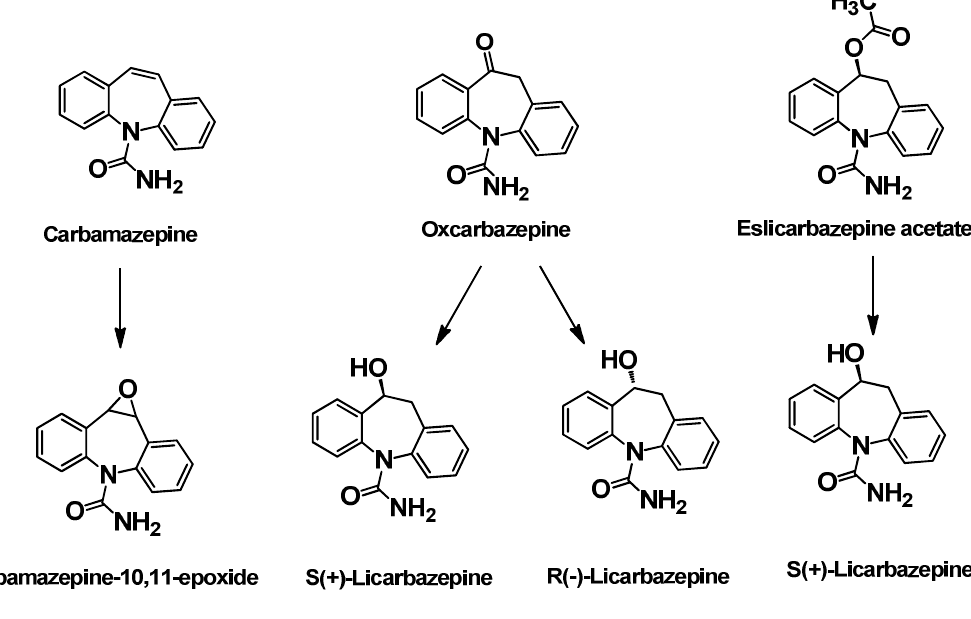
Figure 4. Structures of carbamazepine, new generation analogs and key